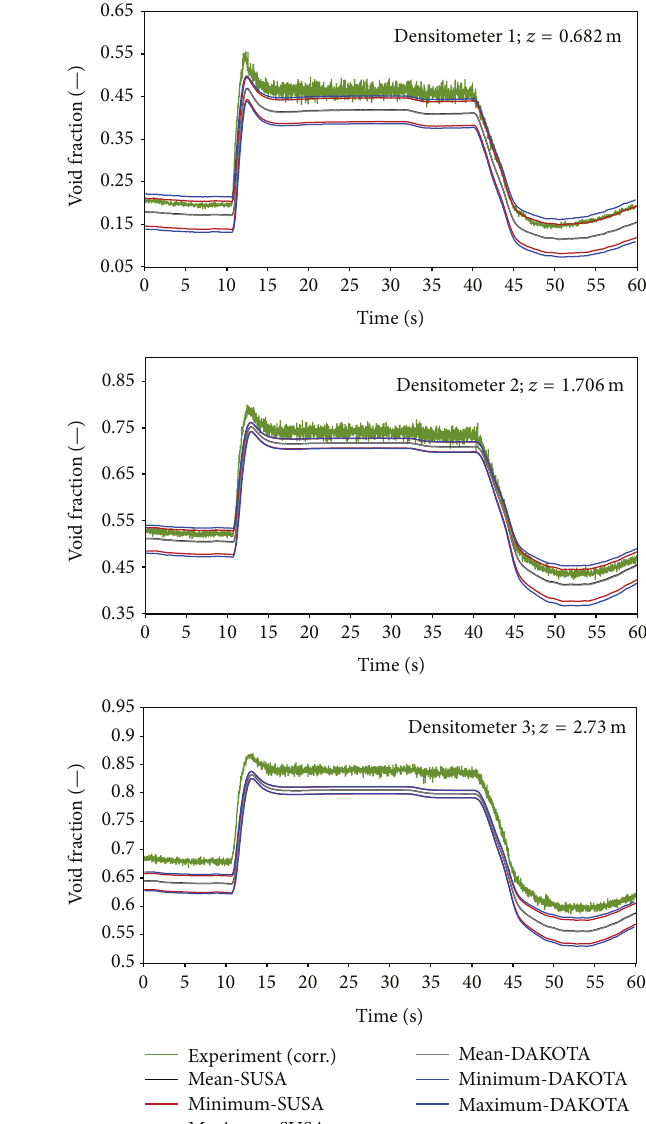
Figure 6: Transient void fraction during the turbine trip at different elevations. Figure 7: Transient void fraction during the pump trip at different